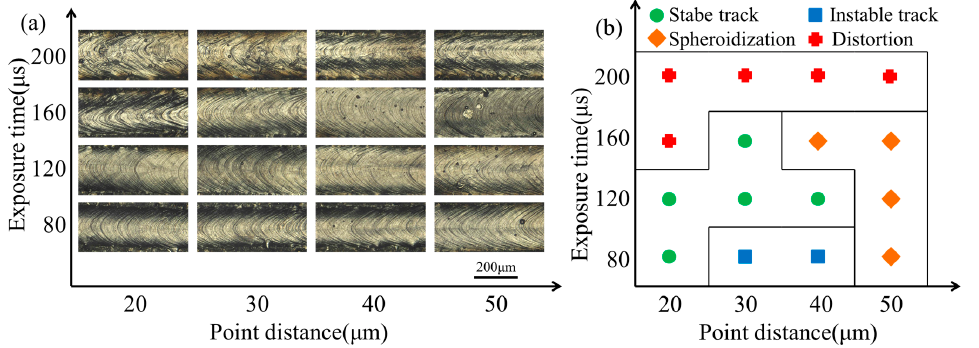
Figure 4. ( a ) Morphologies of single-track experiments; ( b ) process parameter windows of single-track experiments.